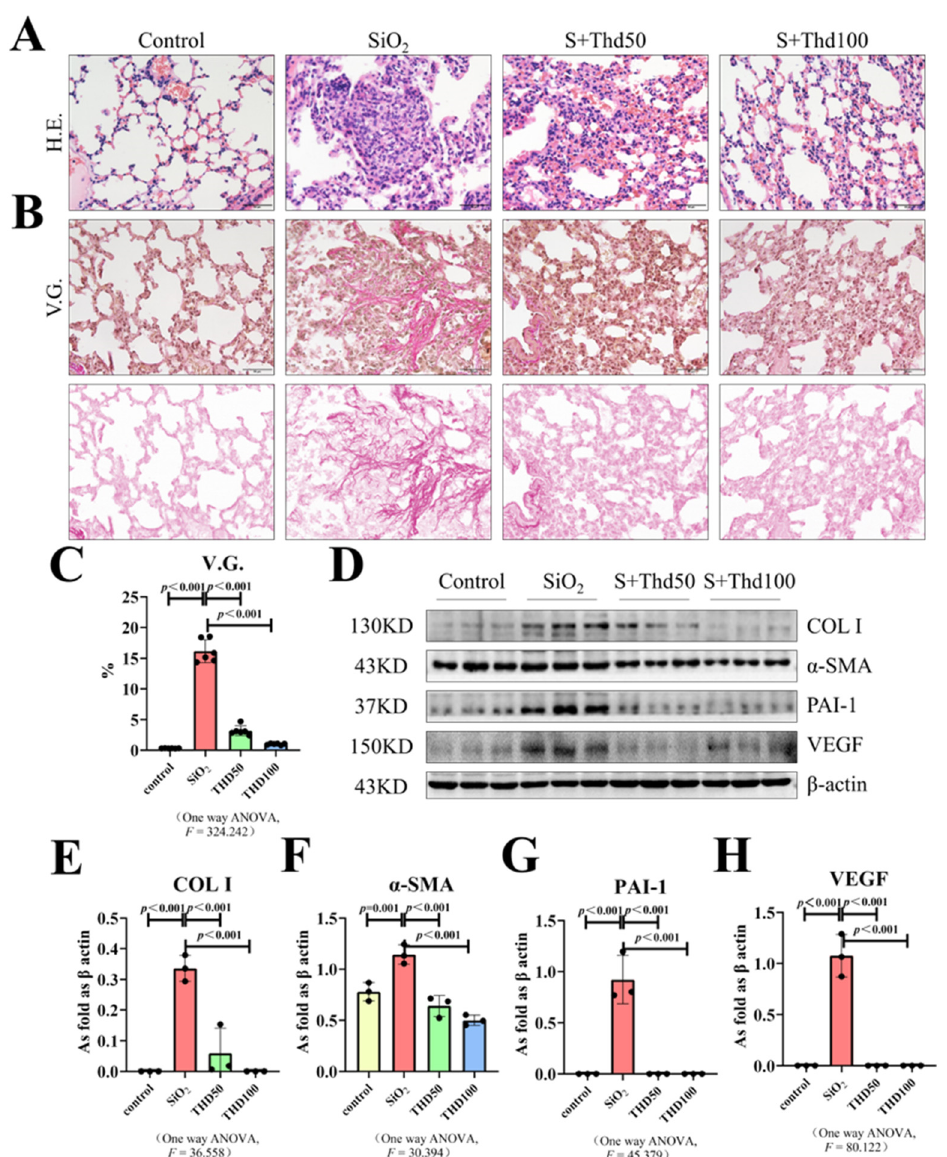
Figure 2. Thalidomide inhibited the progression of fibrosis in silicosis mice. ( A ) HE staining of lung tissue in mice exposed to silica (scale bar = 50 µ m). ( B , C ) V.G. staining of lung tissue in mice exposed to silica (scale bar = 50 µ m). ( D – H ) Expression levels of CoL I, α -smooth muscle actin ( α -SMA), plasminogen activator inhibitor type-1 (PAI-1), and VEGF in the lungs of mice measured by Western blot. Data are presented as the mean ± SD, n = 3 per group.